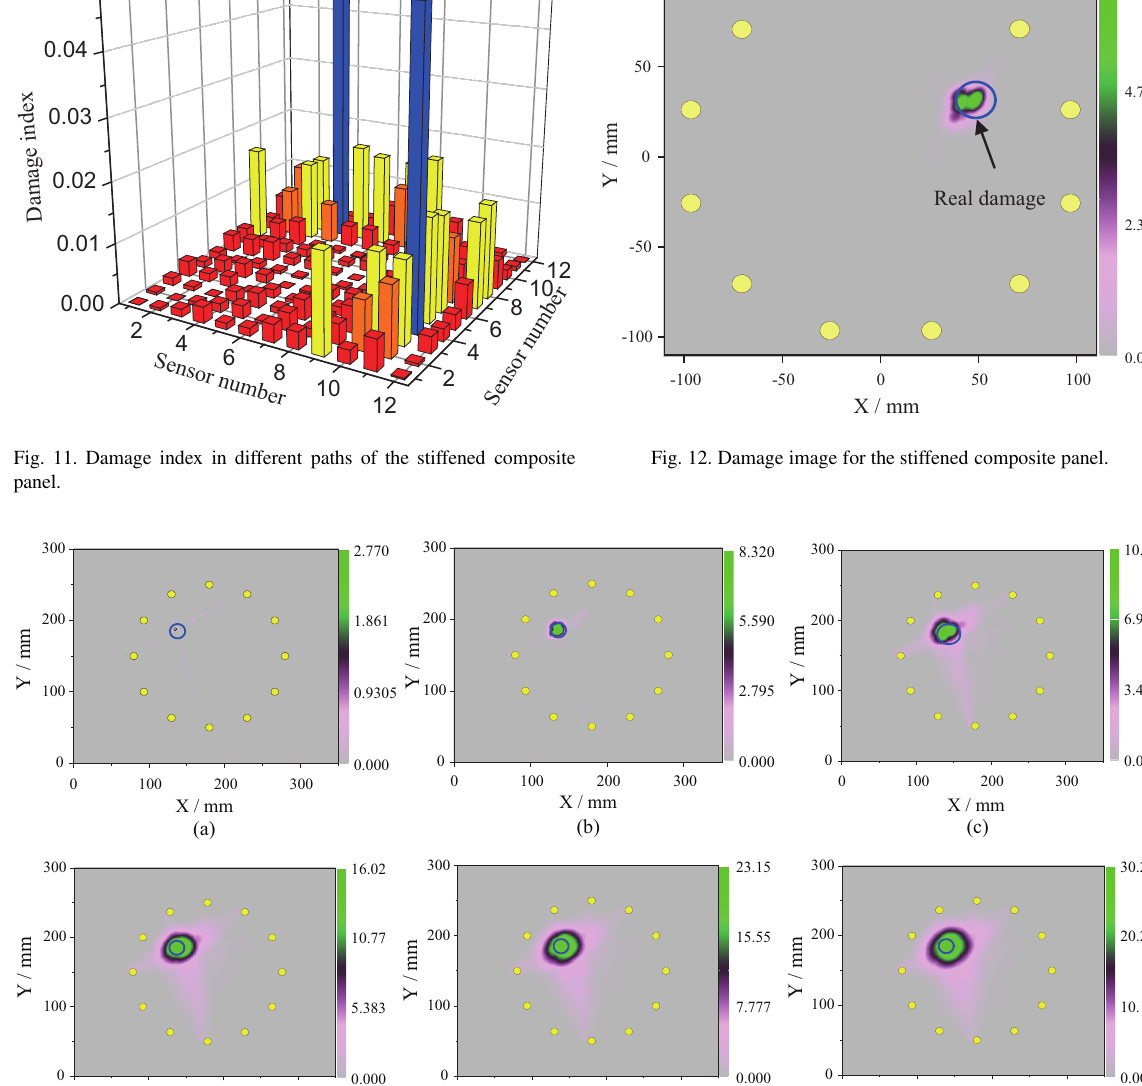
Fig. 13. The influence of the scaling factor β on the imaging result. (a) β = 1.001; (b) β = 1.02; (c) β = 1.04; (d) β = 1.06; (e) β = 1.08; (f) β =